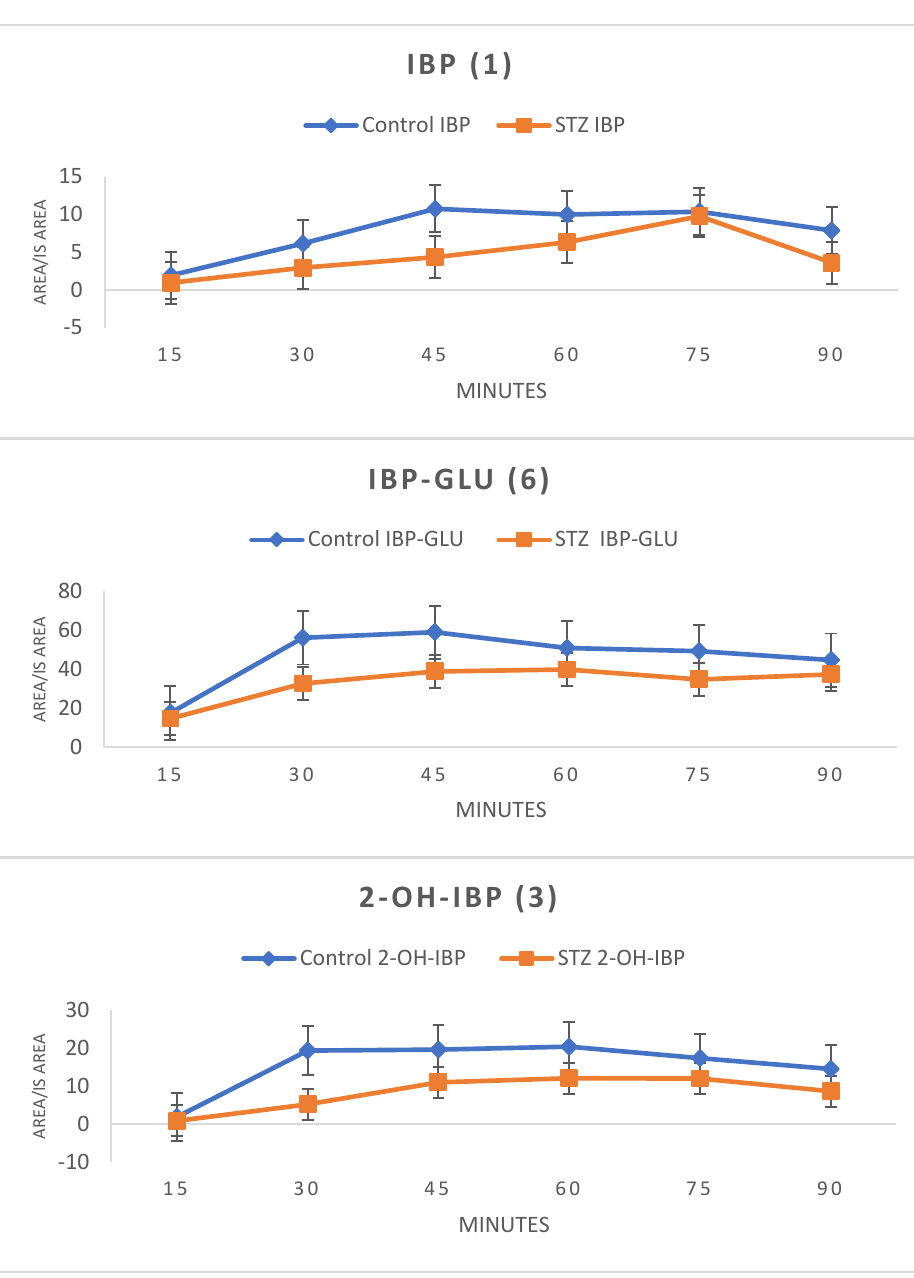
Figure 3 . Change in the HPLC-UV integrated peak areas (relative to the internal standard) of ibuprofen ( 1 ) and the ibuprofen metabolites (IBP-GLU ( 6 ) and 2-OH-IBP ( 3 )) in the diethyl ether extract of bile of control and hyperglycemic (STZ) rats (Method II).